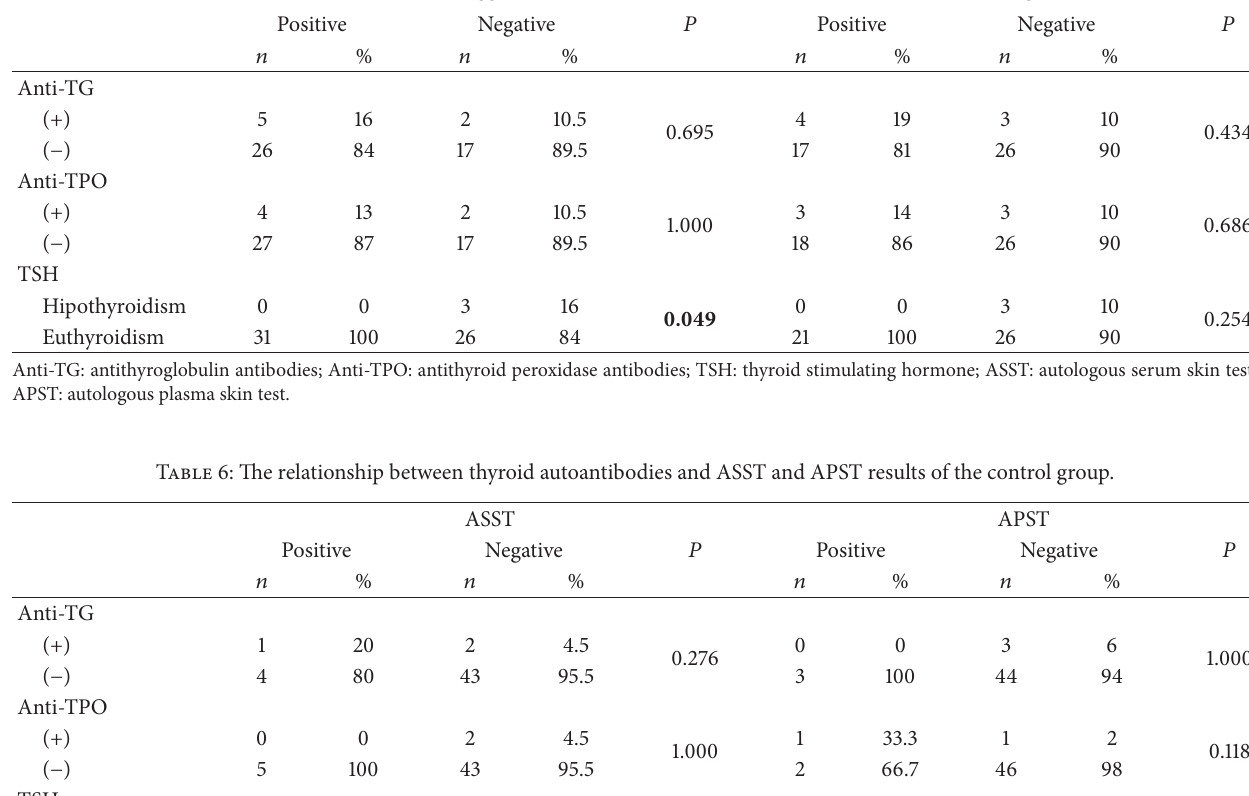
Table 5: The relationship between thyroid autoantibodies and ASST and APST results of the patients. ASST APST